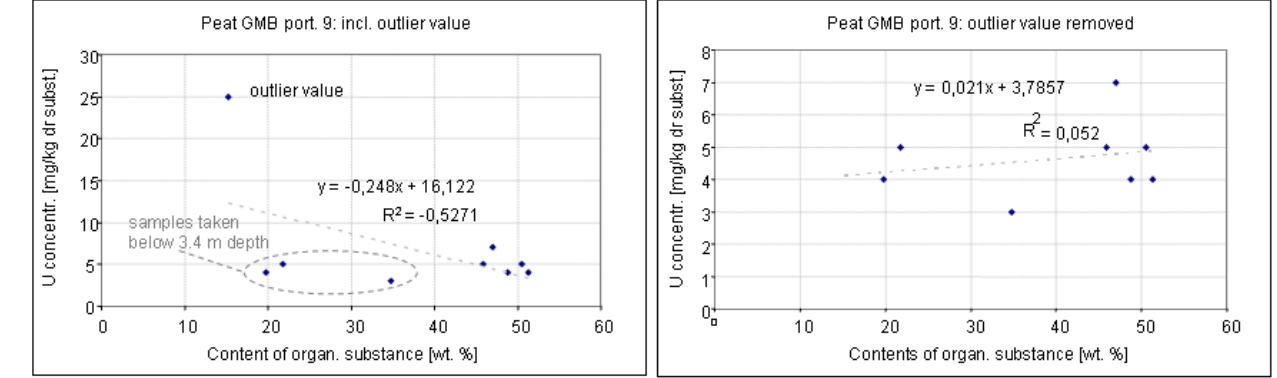
Figure 8. Impact of a possible outlier values on the relationship between the concentration of U and organic substance in peat samples from different depths. Including the outlier value of 25 ppm U results in a weak but still significant correlation (r 2 = 0.527; left diagram) which disappears completely when the unusually high U value is left out (right diagram; r 2 = 0.0052).